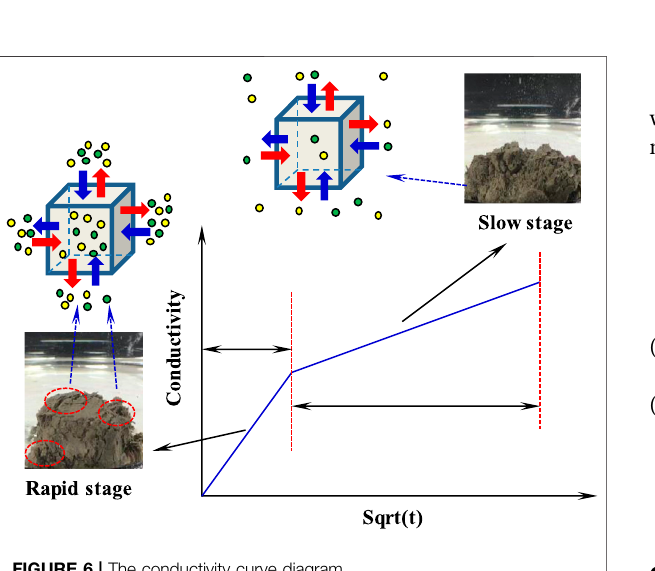
FIGURE 6 | The conductivity curve